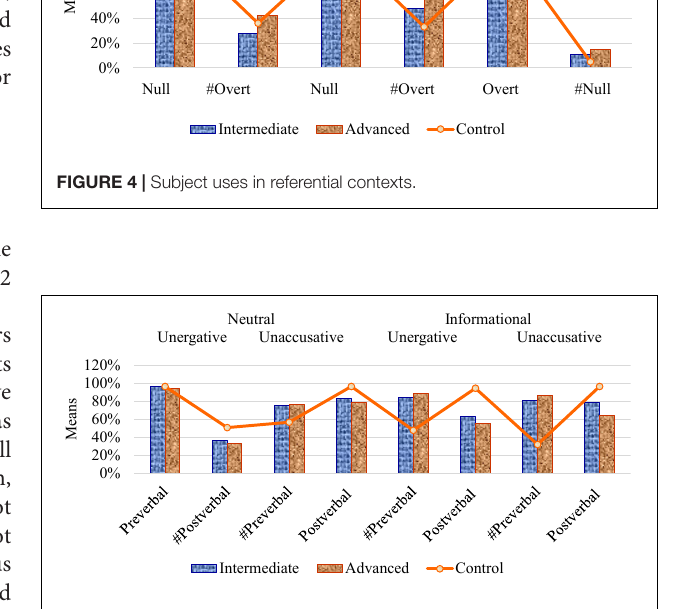
FIGURE 5 | Subject positions in pragmatic